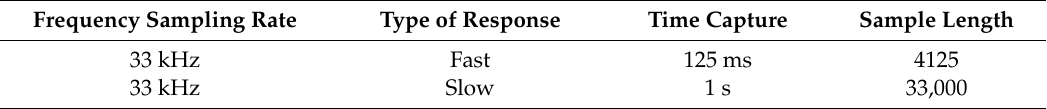
Table 4. The sample length for a frequency-sampling rate of 33